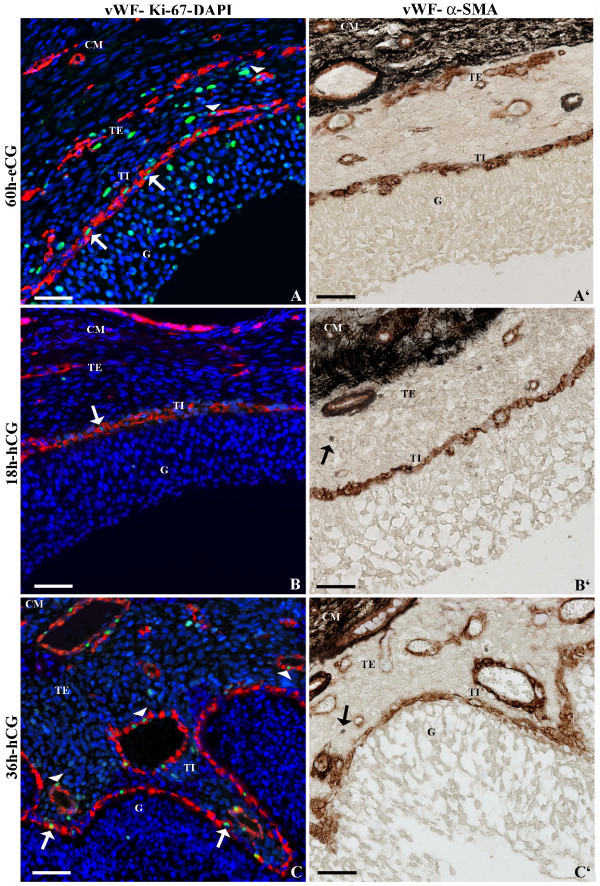
Representative micrograph of immunostaining for vWF, Ki-67 and α-SMA in pre- and periovulatory follicles. In the left panel (A, B, C) intrafollicular distribution of vWF (red stain), an endothelial marker, and Ki-67 (green stain), a cellular proliferative marker that were revealed using a double immunohistochemical technique. The cell nuclei were counterstained with DAPI (blue stain) to visualize the tissue morphology and to identify the follicular compartments. In the right panel (A', B', C') intrafollicular distribution of vWF (brown stain) and α-SMA (black stain) was assessed, by using a double immunohistochemistry. Preovulatory follicles were isolated 60 h after eCG (A, A'), and periovulatory follicles were isolated 18 h (B, B') and 36 h after hCG (C, C'). White arrows and white arrowheads indicate proliferating endothelial cells in the inner and outer network, respectively. In periovulatory follicles black arrows indicate single α-SMA immunopositive cells. G = granulosa compartment; TI and TE = inner and external (outer) theca compartment, respectively; CM = capsule of smooth muscular fibres. Bar = 100 μm.